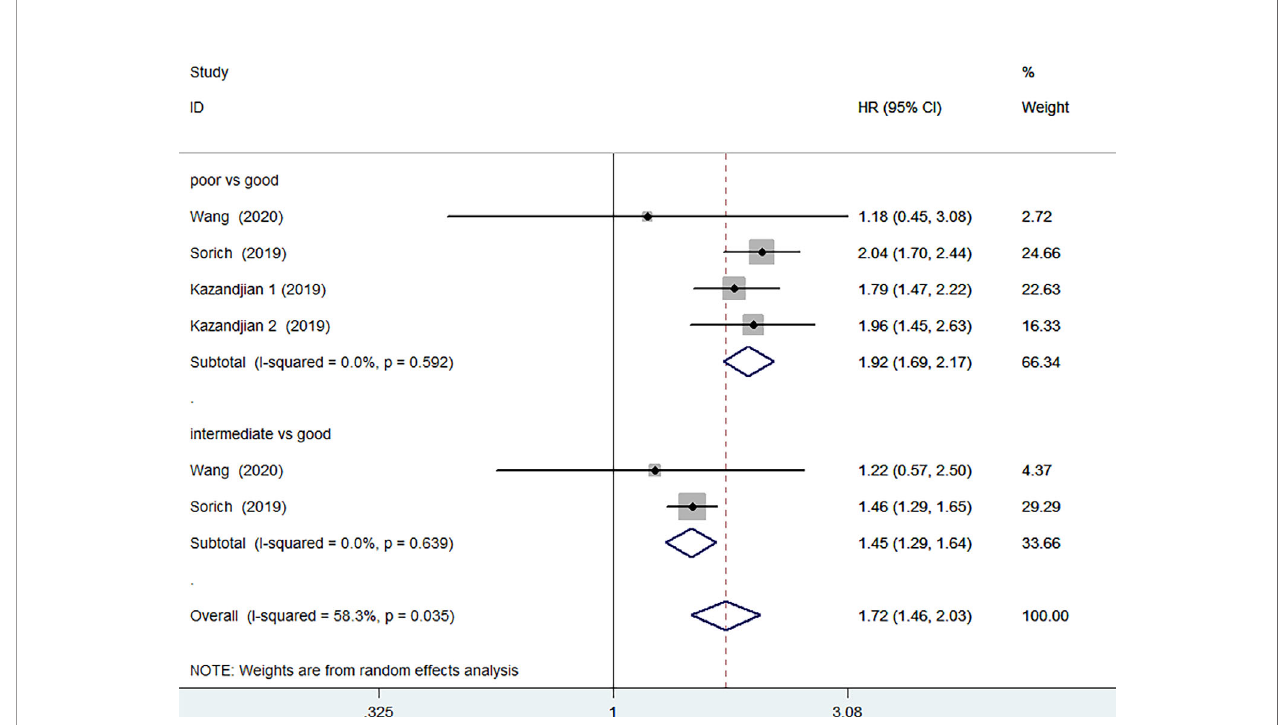
FIGURE 6 | Meta-analysis of PFS in cancer patients after chemotherapy (poor LIPI score groups vs. good LIPI score groups, intermediate LIPI score groups vs. good LIPI score